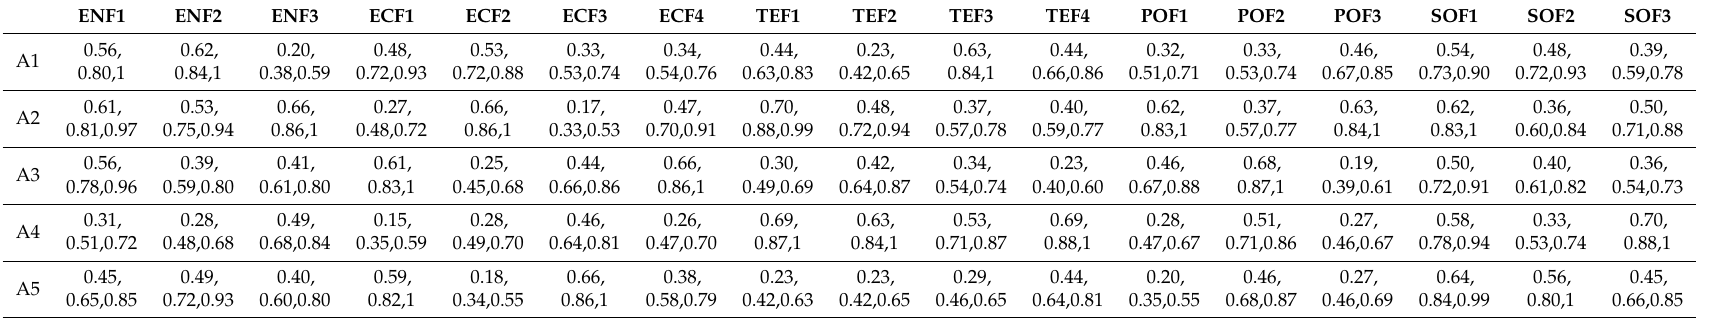
Table A10. Fuzzy normalized decision